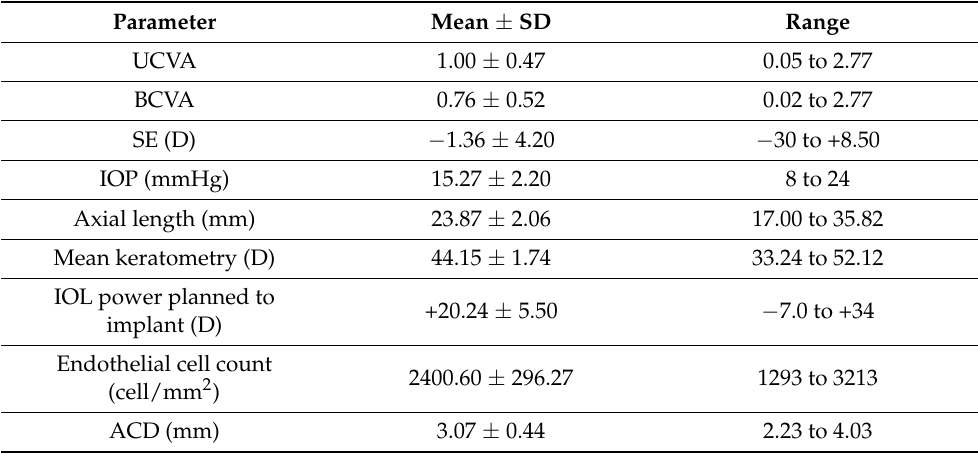
Table 1. Means, standard deviation (SD) and ranges of ocular preoperative features: uncorrected visual acuity (UCVA) and best corrected visual acuity (BCVA) in LogMar, spherical equivalent (SE) in diopters (D), intraocular pressure (IOP), axial length, mean keratometry, intraocular lens (IOL) power planned to implant, endothelial cell count and anterior chamber depth (ACD).